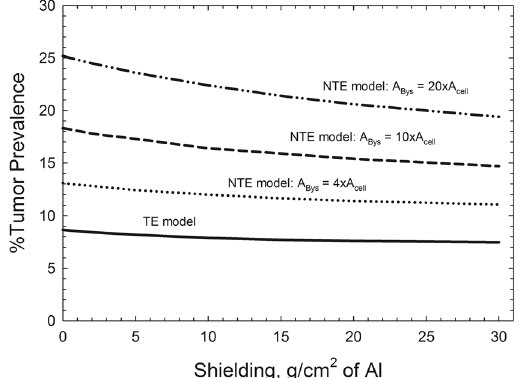
Figure 5. Predictions of % tumor prevalence for 1-year galactic cosmic ray (GCR) exposures at solar minimum versus aluminum shielding depth in targeted effects (TE) and non-targeted effects (NTE) model. Calculations assume 5 cm of tissue equivalent shielding and explore NTE predictions for several assumptions on the area encompassed by bystander cells susceptible to oncogenic signals from directly traversed cells.